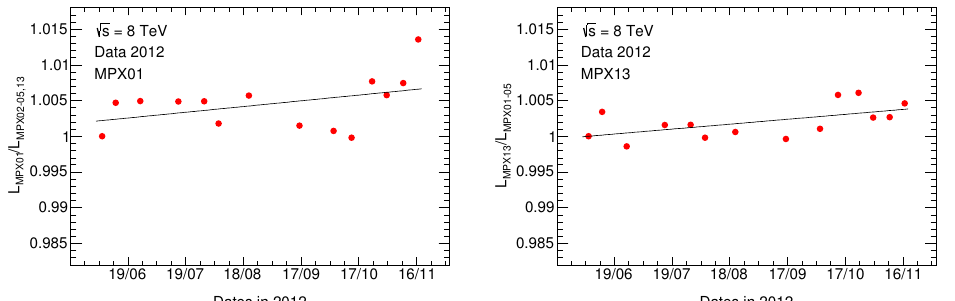
Figure 6. Time history of the luminosity ratio MPX/MPXav for two of the six MPX devices (MPX01 and MPX13) with highest particle flux (MPX01-05 and MPX13) used for hit counting. A linear fit is applied to determine the slopes. The 2012 data are divided into 14 time periods with an equal number of LBs. The data are scaled such that the value of the first bin is unity. The size of the statistical error bar is below the size of the data point. It is identical for every data point of the same device. The size of the error bar which would give χ 2 /ndf = 1 is given in Table 3 for each MPX device. LHC fills from June to November 2012. The “ndf” stays for “number of degrees of freedom”. Taken from Ref. [11]. A linear fit is applied to the MPX/MPXav luminosity ratio versus time for the June to November 2012 data-taking period. The slope of the linear fit is taken as a measure of time stability. The obtained slope values and their uncertainties are summarized in Table 3. The variance of these slope measurements is 0.69 [% per 200 days] 2 . The resulting standard deviation of 0.83 [% per 200 days] is used as an estimation of the systematic uncertainty. Table 3. Slope of time history of the luminosity ratio MPX/MPXav for the six MPX devices with highest particle flux (MPX01-05 and MPX13) used for hit counting. The slope values and the uncertainties are given per second, and in percentage for 200 days. For a realistic slope uncertainty determination of an individual device, the errors are scaled to obtain χ 2 /ndf = 1. σ R is the size of the error bars which are the same for each data point (Figure 6). Taken from Ref. [11].